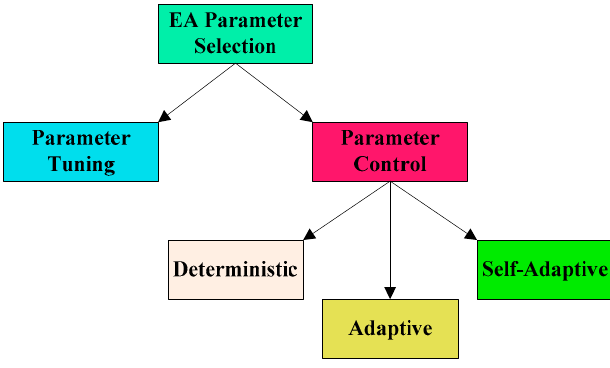
Figure 1. EA parameter selection approaches.